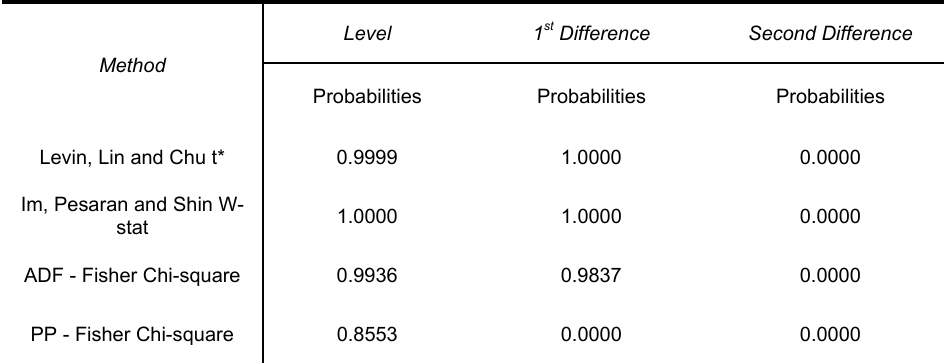
Table 4: Unit Root Test (Urban